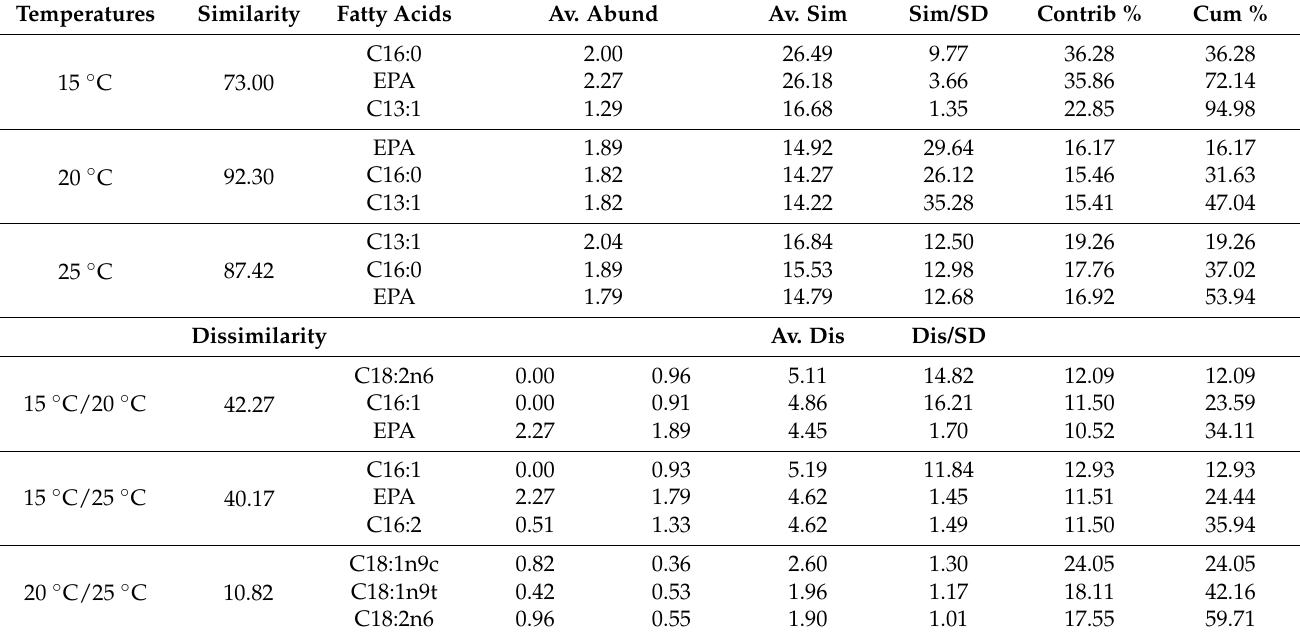
Table 5. SIMPER analyses showing average similarity and dissimilarity among groups of samples, related with n-MDS analysis. Temperatures